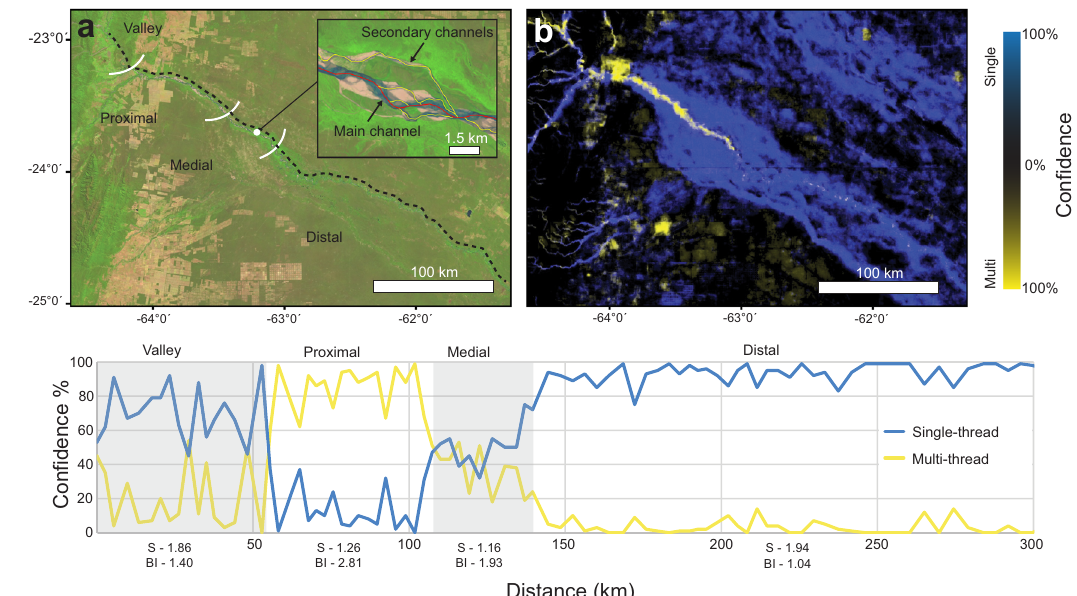
Fig. 6 | Example river morphology pro fi le. a Shows the original 2020 Landsat 8 imagery of the Rio Bermejo in Argentina. The dotted line is the pro fi le used to sample the morphology of the active river channelevery5km ’ s for the plot shown below. b ShowstheresultingpredictionfromtheGlobalChannelBelt(GCB)model indicating the gradual multi-threaded to single-threaded trend common in many